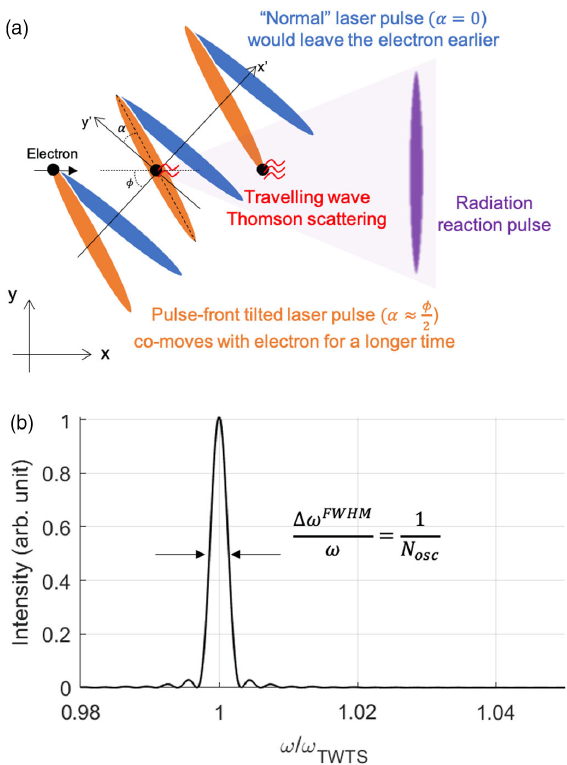
FIG. 1. (a) Geometry of TWTS, for which the pulse-front tilted laser pulse is spatiotemporally locked with the relativistic electron. The normal pulse, without pulse-front tilt, slips out of the electron after a short distance of propagation. Another pulse can be added, for example, to investigate the radiation reaction process; (b) A typical spectrum of TWTS. Due to the small amplitude of the TWTS laser field, the central x-ray photon energy is the linear limit [Eq. (6)]. The bandwidth is inversely proportional to the number of electron oscillations in TWTS laser field, or equivalently, inverse proportional to the traveling-wave